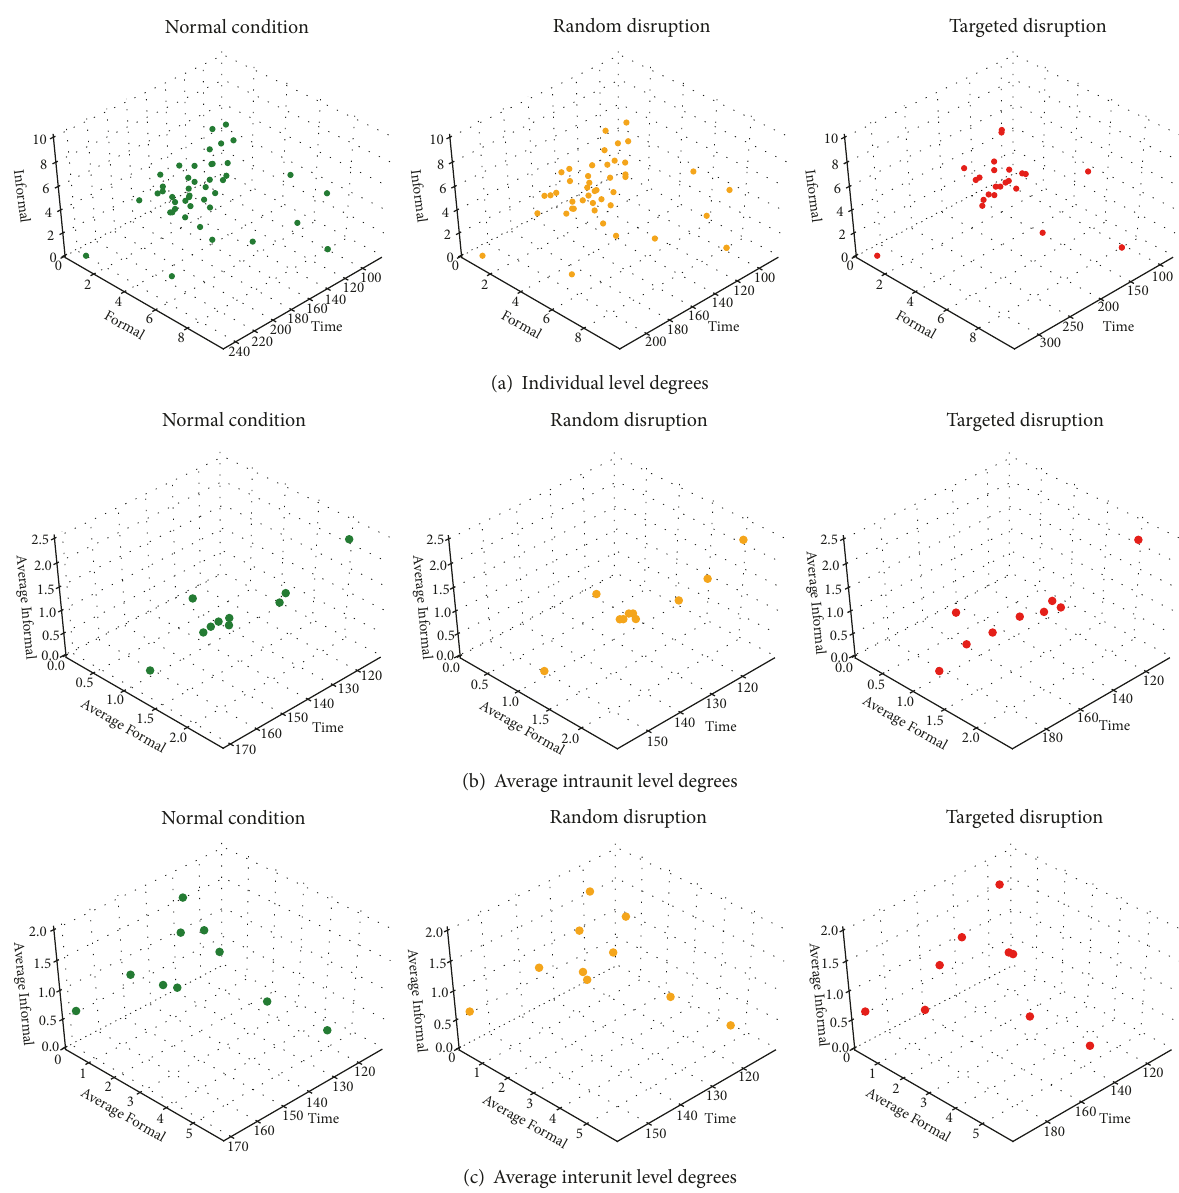
Figure 7: Relation between average interunit level degrees and task performance in normal and disrupted conditions.